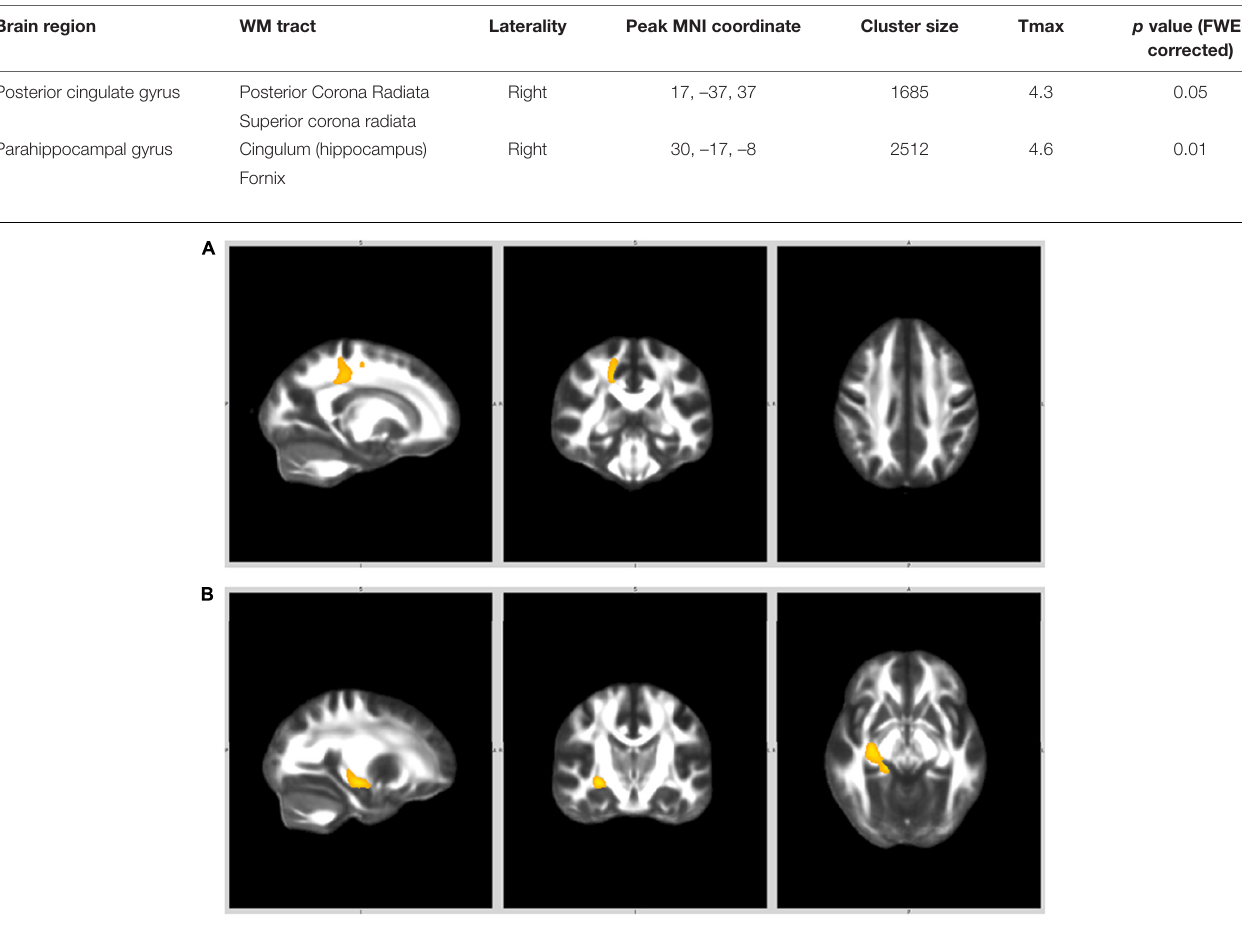
TABLE 2 | Areas with decreased FA values in FEP vs. HC in the whole-brain analysis at a cluster level.